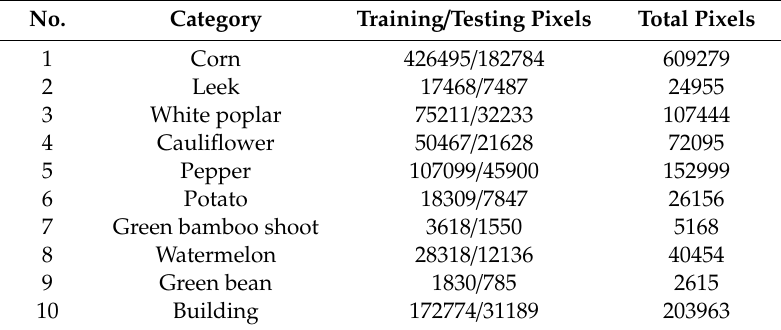
Table 2. The numbers of the training and test samples for various ground objects.